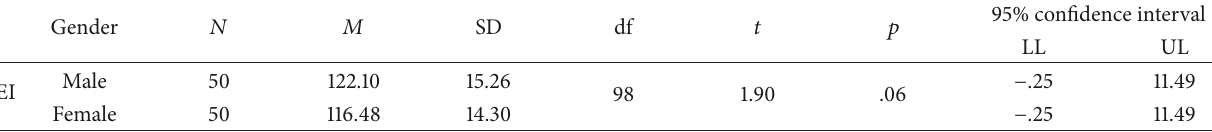
Table 8: Mean, standard deviation, and 𝑡 -values on procrastination and self-regulation ( 𝑁 = 100 ).